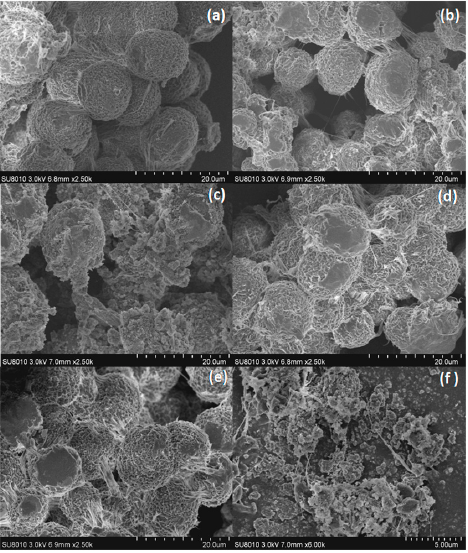
Figure 5. SEM results of ( a ) PP, ( b ) PP/10% APP-LDH, ( c ) PP/20% APP-LDH, ( d ) PP/2% ZB, ( e ) PP/10% APP-LDH/2% ZB, and ( f ) PP/20% APP-LDH/2% ZB nanocomposites.